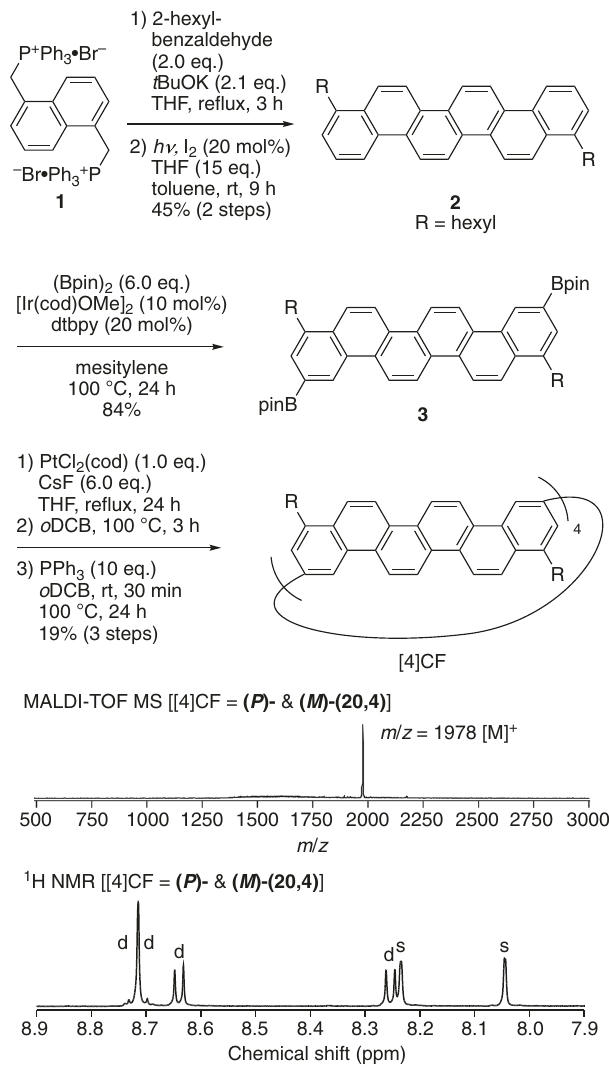
Fig. 3 Synthesis of [4]CF [( P )- and ( M )-(20,4)]. Bpin = 4,4,5,5- tetramethyl-1,3,2-dioxaborolan-2-yl, cod = 1,5-cyclooctadiene, dtbpy = 4,4 ′ -di- t -butyl-2,2 ′ diameter of 1.77 nm. Thus, the isomers of [4]CF with D 4 -sym- metric ( P )- and ( M )-(20,4)-[4]CF, which are hereafter denoted as ( P )-(20,4) and ( M )-(20,4) , became our target as an outer cylindrical molecule for i-DWNT complexes.